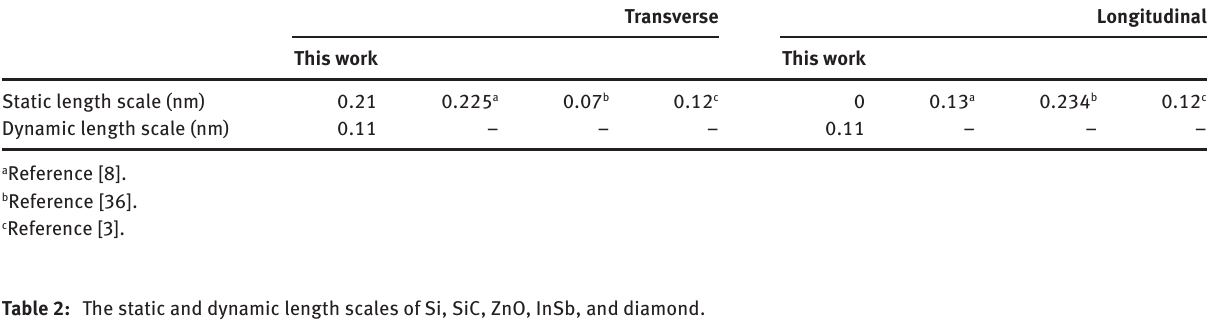
Table 2: The static and dynamic length scales of Si, SiC, ZnO, InSb, and diamond.